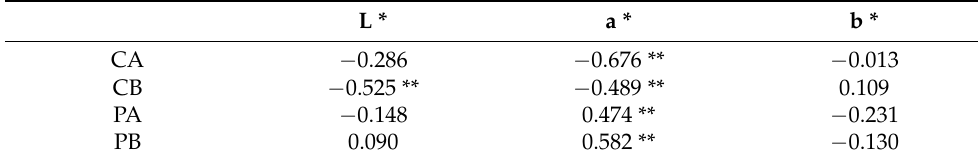
Table 3. Pearson correlation coefficients (r) between chlorophyll and pheophytin content and